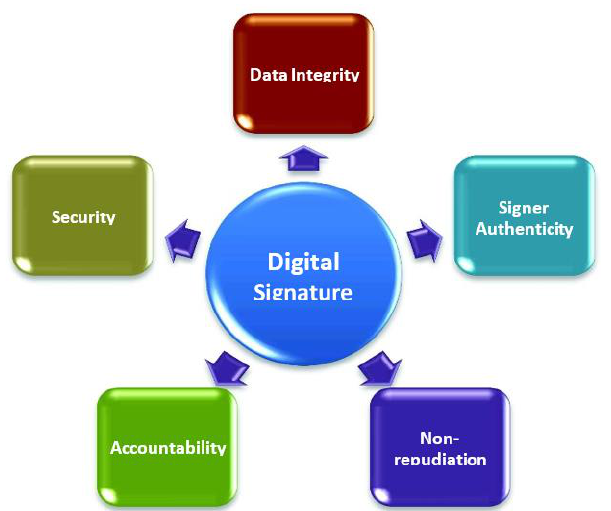
Figure 1. Security Advantages of Digital Signatures.